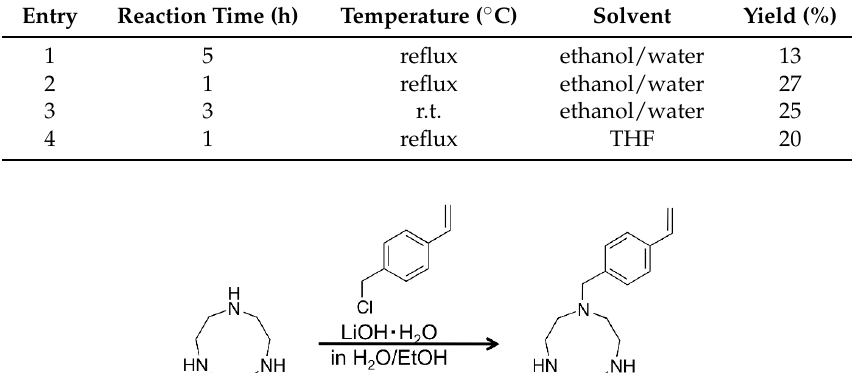
Table 1. N -(4-Vinylbenzyl)-1,4,7-triazacyclononane (VinylTACN) synthesis (TACN/vinyl benzyl chloride = 5:1).